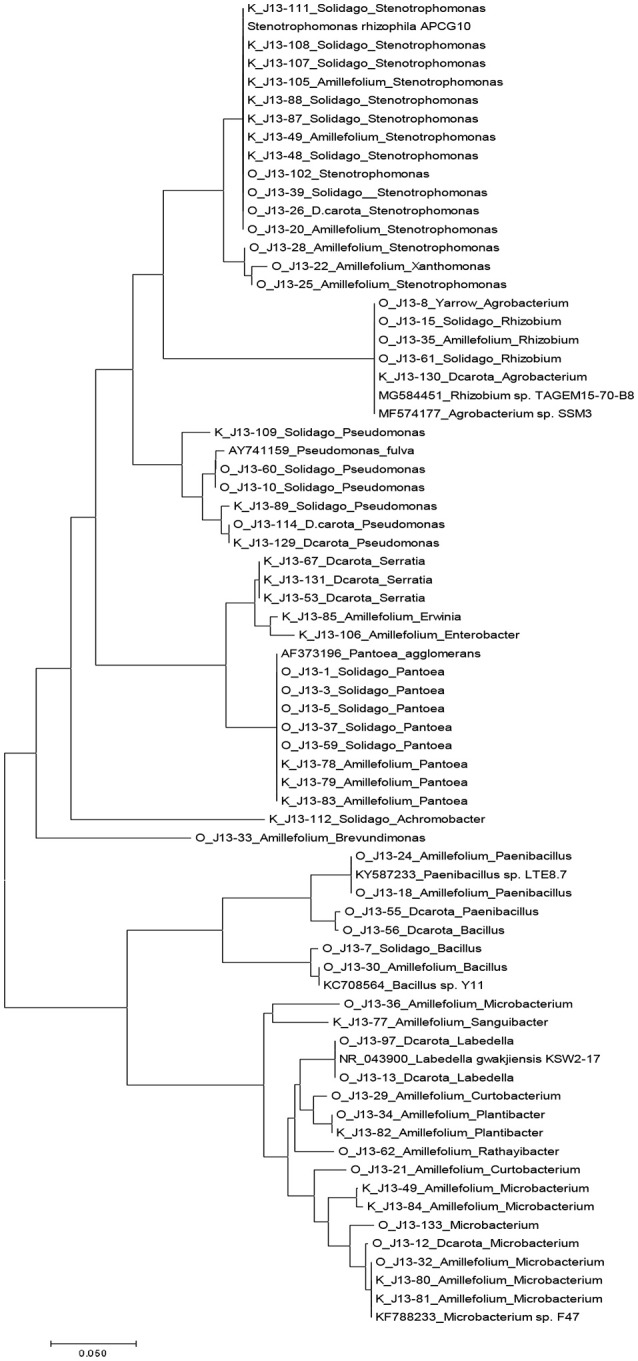
Phylogenetic tree based on partial 16s sequences inferred using the Neighbor-Joining method. The evolutionary distances were computed using the maximum composite likelihood method in MEGA7 (Kumar et al., 2016). Strains that do not have J13 labels are sequences from Genbank database.